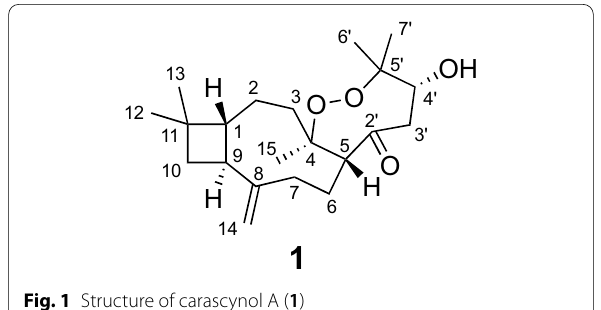
Fig. 1 Structure of carascynol A ( 1 )